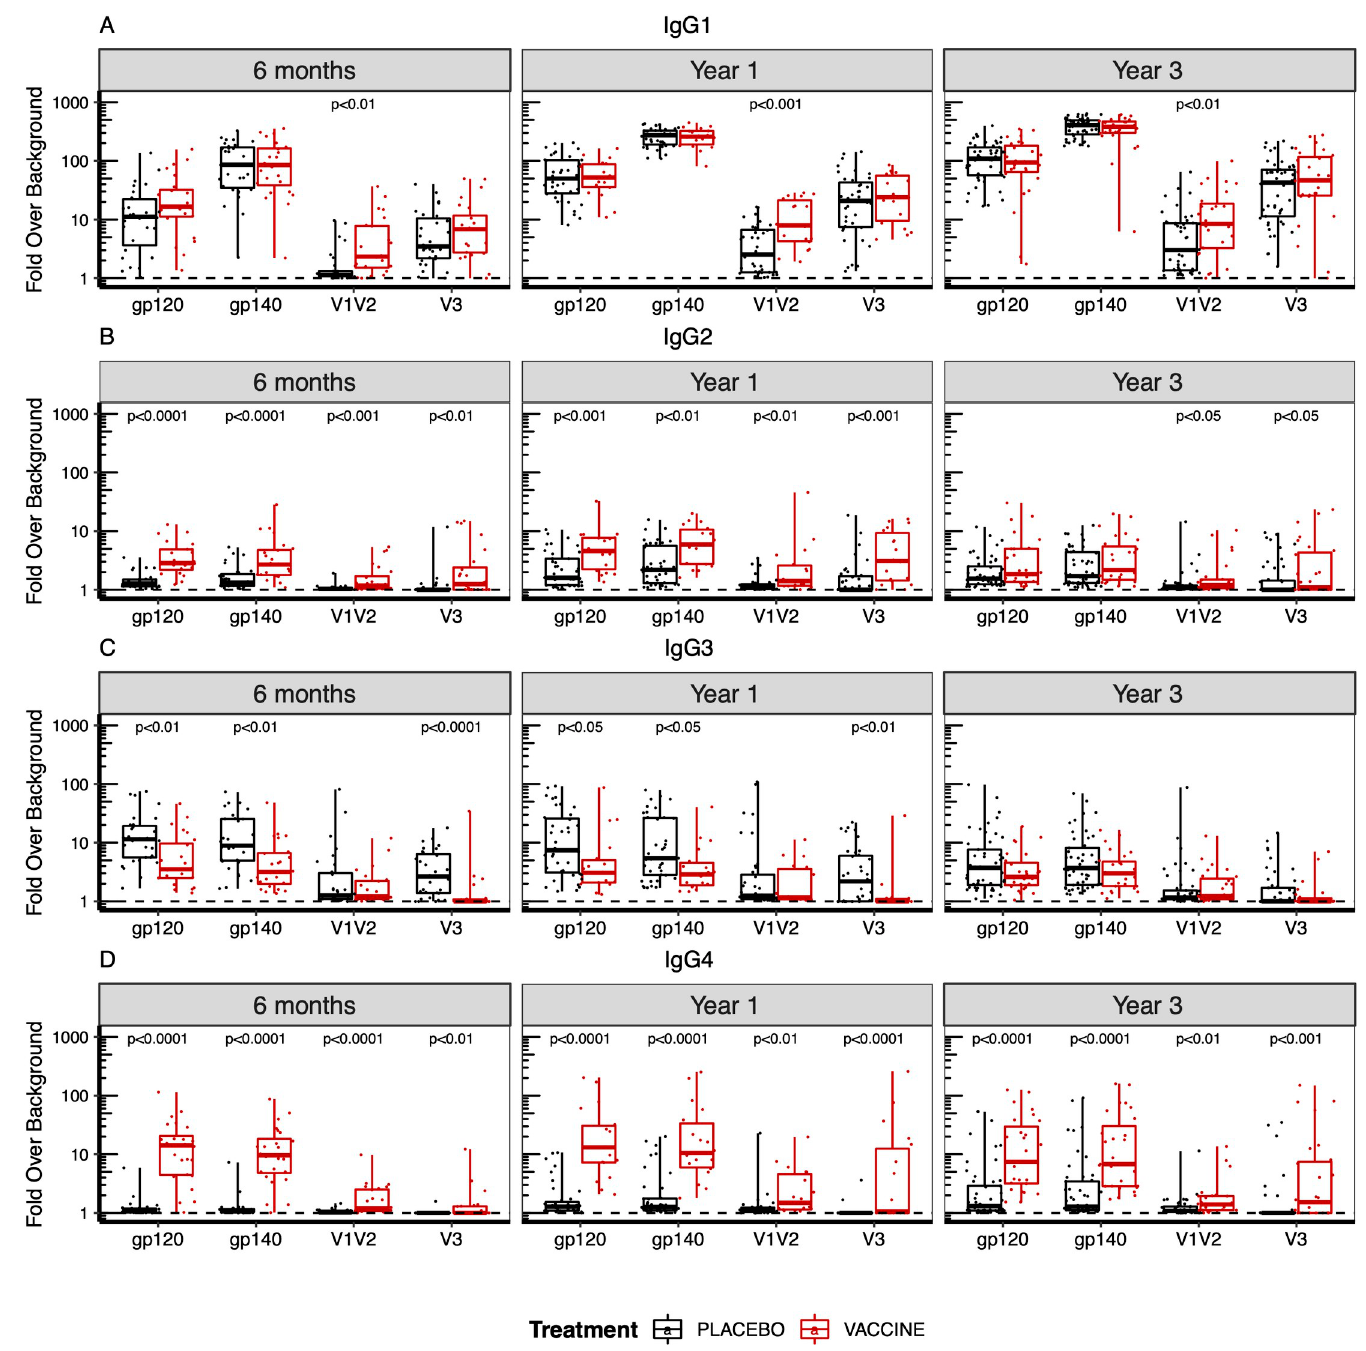
Fig 2. B cell priming in vaccine recipients altered subclass and antibody specificity to HIV-1 following infection. (A) IgG1, (B) IgG2, (C) IgG3, and (D) IgG4 subclass binding to HIV-1 Env antigens at 6 months (N = 24 vaccine, 31 placebo), one year (N = 18 vaccine, 39 placebo), and three years (N = 27 vaccine, 49 placebo) post-HIV-1 diagnosis. The fold over background is represented for each Env antigen as a composite score corresponding to the geometric mean of the fold over background across the different antigens tested: 9 gp120s, 23 gp140s, 6 V1V2 gp70 and 4 V3 gp70 antigen. P values were calculated by Mann-Whitney U test and adjusted by False Discovery Rate (FDR) for multiple comparisons. Only significant (p < 0.05) p values are shown.